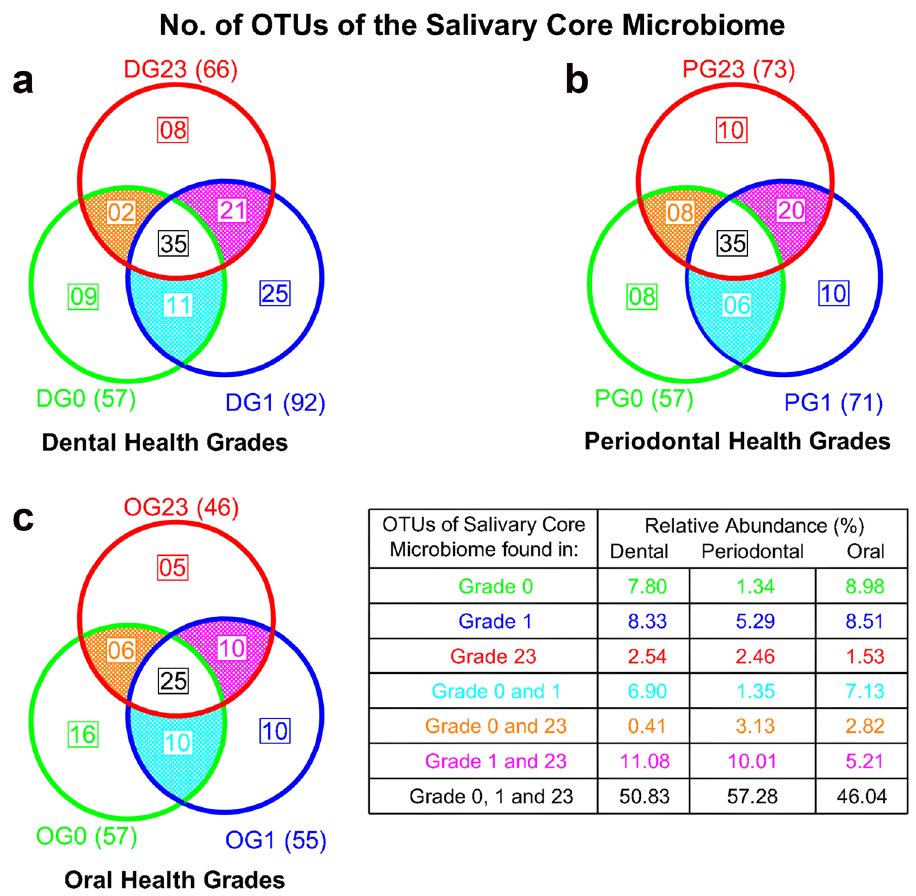
Figure 2. Number of OTUs of the salivary core microbiome present in different grades of dental, periodontal and oral health, as well as their respective relative abundance